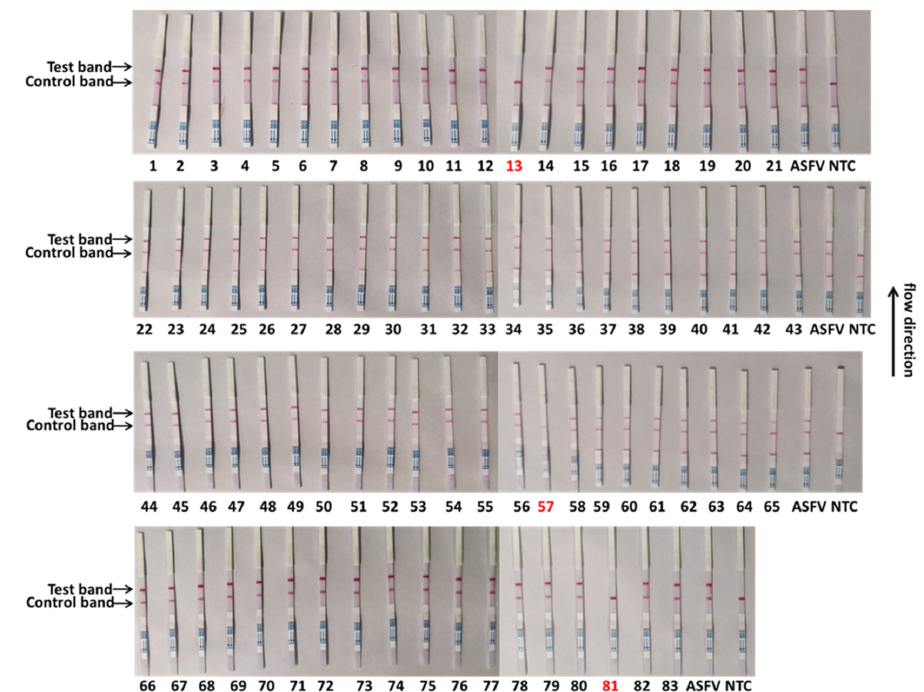
Figure 5. Clinical sample detection by the CRISPR/Cas13a-LFD. The samples marked with black numbers were ASFV-positive samples, and the samples marked with red numbers were negative samples. Eighty-three samples were used for testing.